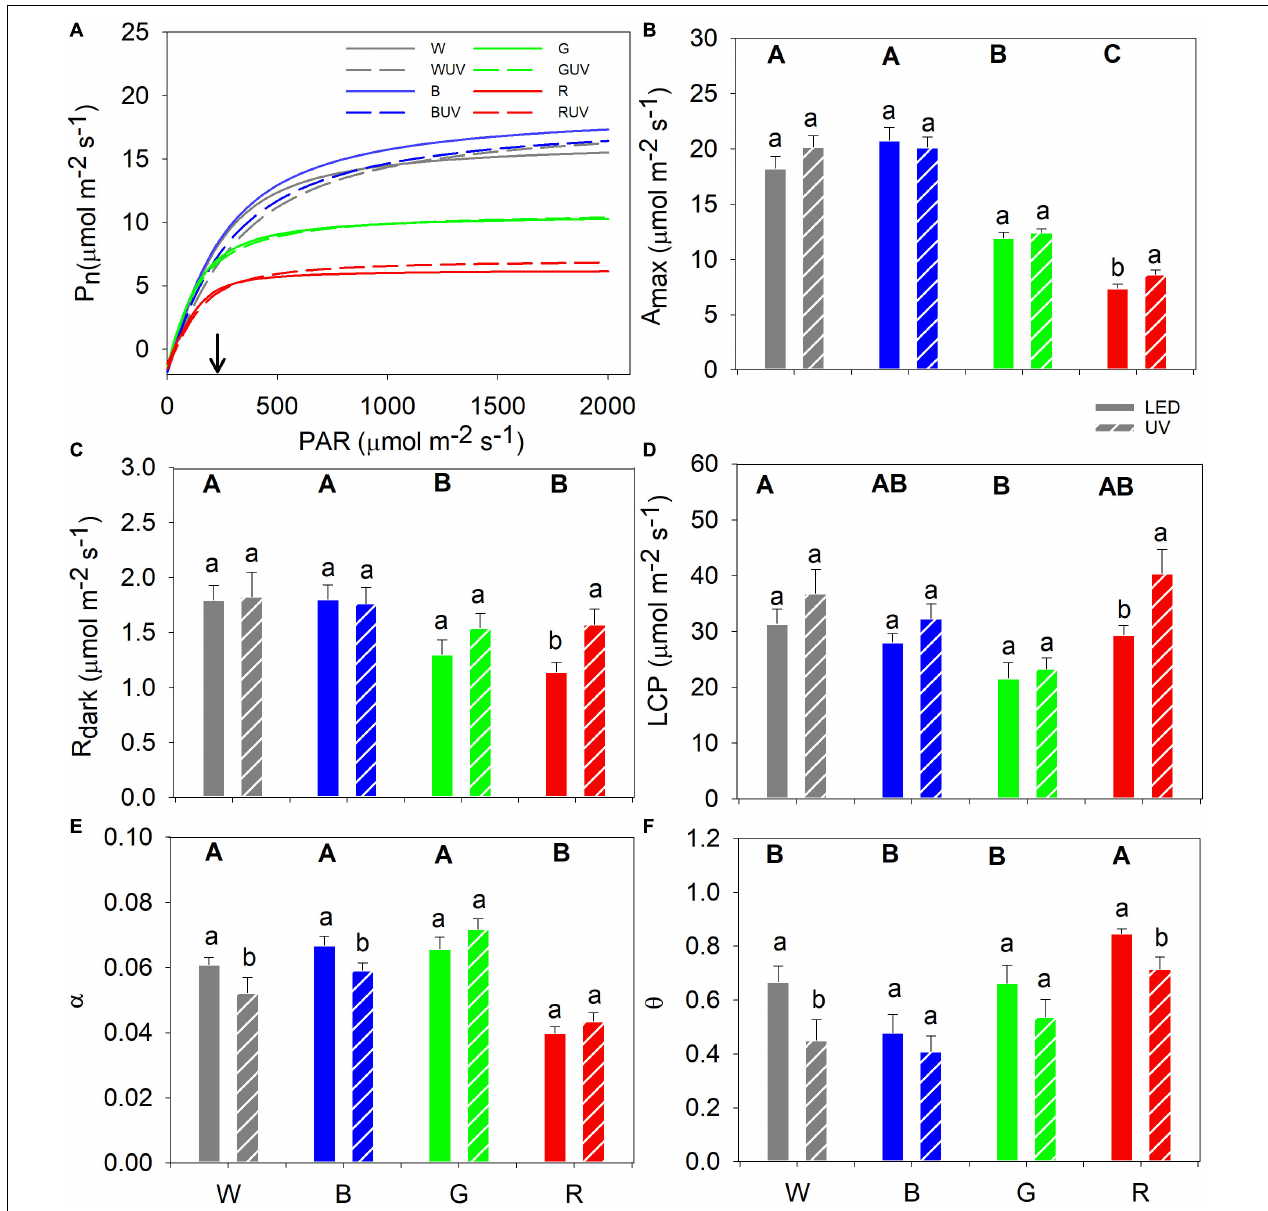
FIGURE 3 | (A) Fitted light response curves of cucumber grown under four LED light backgrounds (White, Blue, Green, and Red) without (solid bars) and with (dashed bars) exposure to supplementary UV-B radiation for 14 days [for variation of the data at light saturation refer from panels (B–F) ], where the arrow indicates the growth PAR. Curve fitted parameters: (B) Maximum net assimilation rate (A max ); (C) Dark respiration (R dark ); (D) Light compensation point (LCP); (E) Apparent quantum yield of photosynthesis ( α ); and (F) convexity ( θ ). Bars represent the mean values ( n = 21 ± SE). Capital letters indicate significant differences between growth light qualities without UV-B and lower-case letters between non-UV-B-exposed plants and UV-B-exposed plants within the same PAR background, both at P < 0.05.